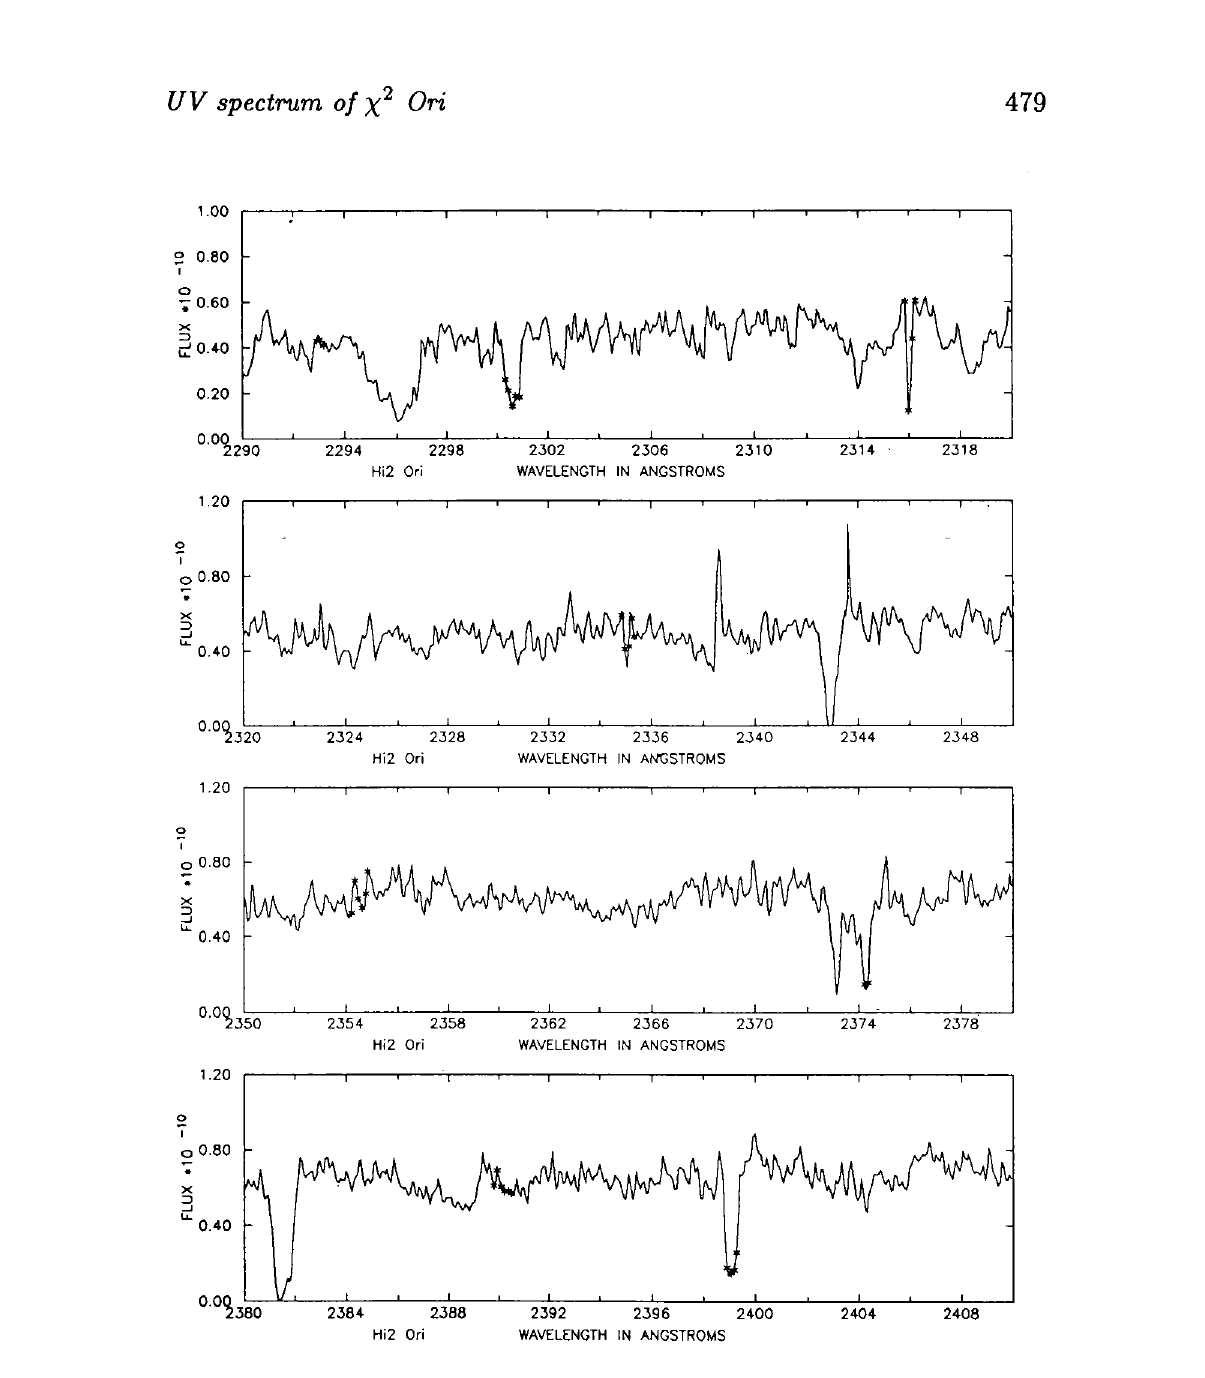
Fig. 13. LWR spectrum of x 2 Ori for spectral region 2290-2410